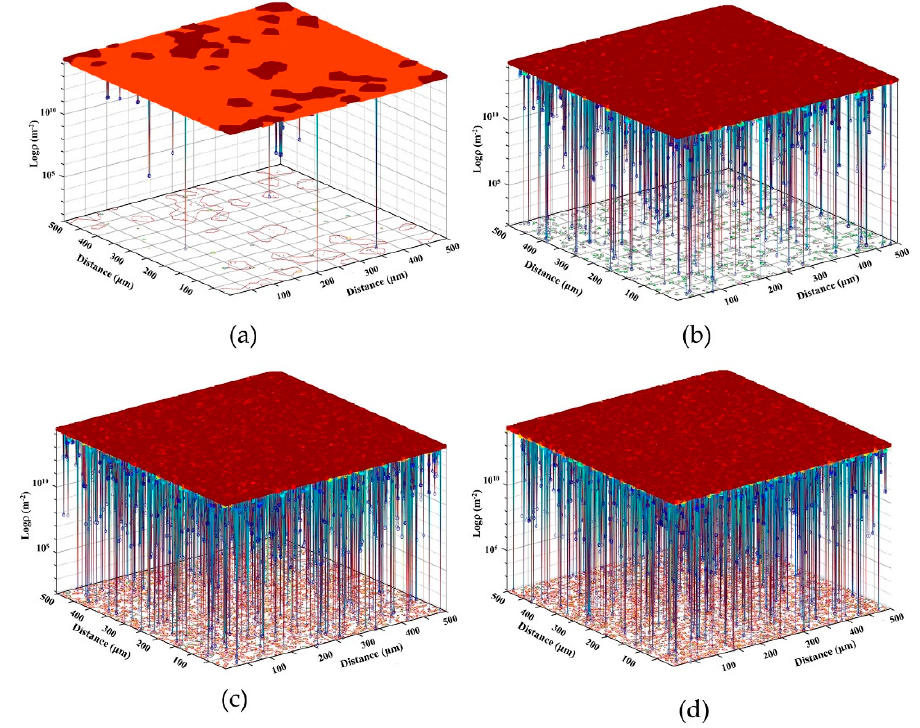
Figure 10. Dislocation density distribution of T15MN HSS during DRX at 1323 K and 0.01 s − 1 via CA method with various strains of ( a ) 0.05; ( b ) 0.3; ( c ) 0.6; ( d ) 0.9. method with various strains of ( a ) 0.05; ( b ) 0.3; ( c ) 0.6; ( d )